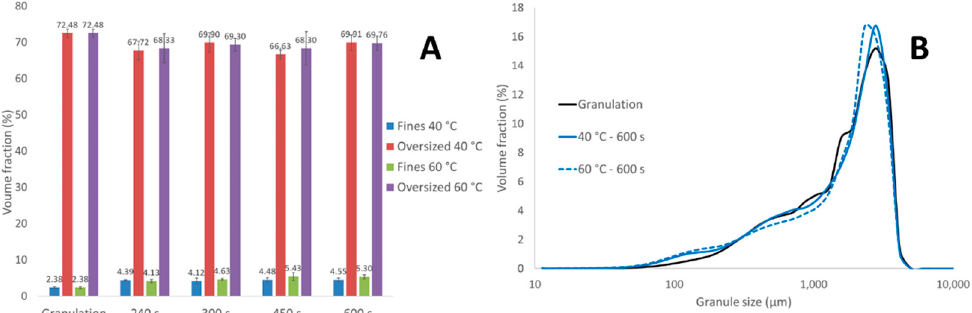
Figure 9. The fraction of fines and oversized granules after granulation and at different drying time points on the C1 ( A ). Granule size distribution after 600 s of drying at 40 and 60 °C of drying air temperature ( B ).